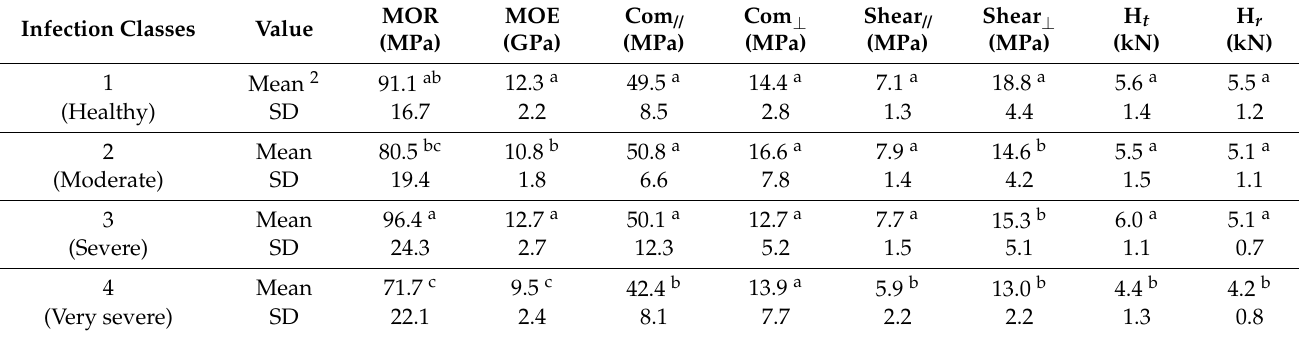
Table 6. Effects of infection by Crysoporthe deuterocubensis on mechanical properties of Eucalyptus urograndis lumber 1 . Infection